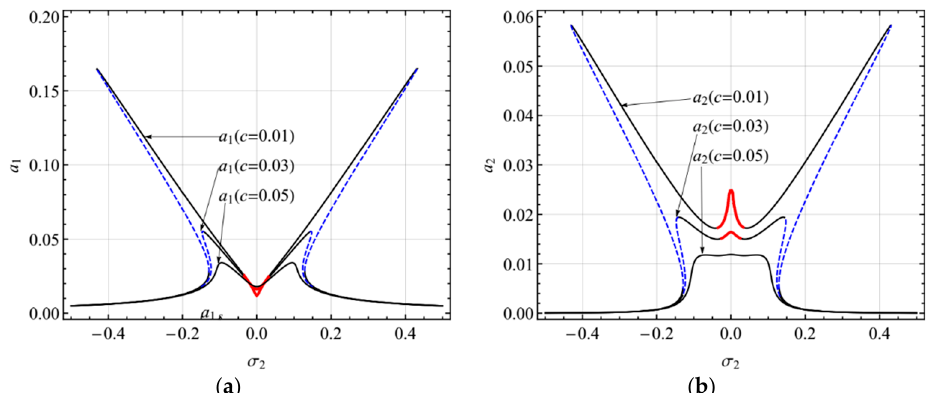
Figure 4. Frequency-response curves of primary resonance of the first mode for c = 0.01, 0.03, 0.05; ( a ) the first mode, ( b ) the second mode.